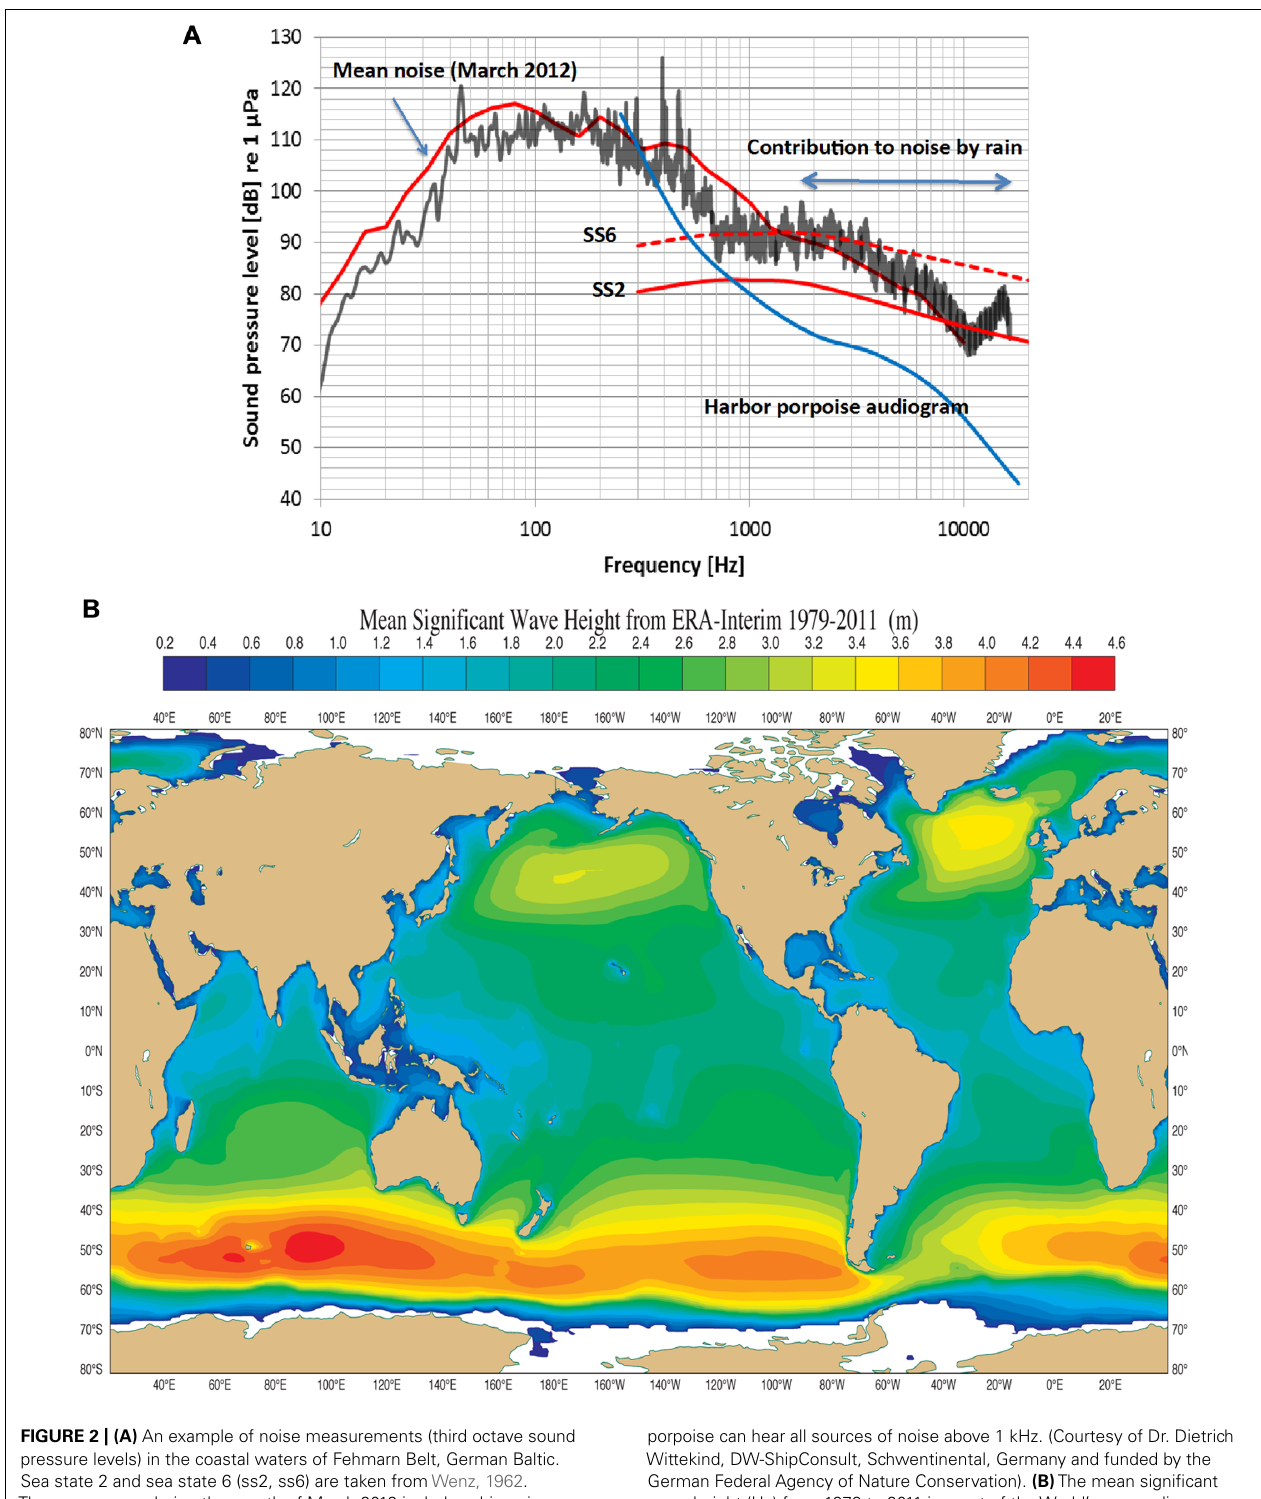
FIGURE 2 | (A) An example of noise measurements (third octave sound pressure levels) in the coastal waters of Fehmarn Belt, German Baltic. Sea state 2 and sea state 6 (ss2, ss6) are taken fromWenz, 1962. The mean curve during the month of March 2012 includes ship noise, which contributes mostly below 1 kHz.The black curve is a 20 min measurement of noise during rain (30–40 mm/h) during sea state 2, raising the noise level from 5 to 10 dB.The “contribution to noise by rain” begins to die out above 16 kHz.The blue curve is the lower portion of a harbor porpoise audiogram (Kastelein etal., 2002). Note that the harbor